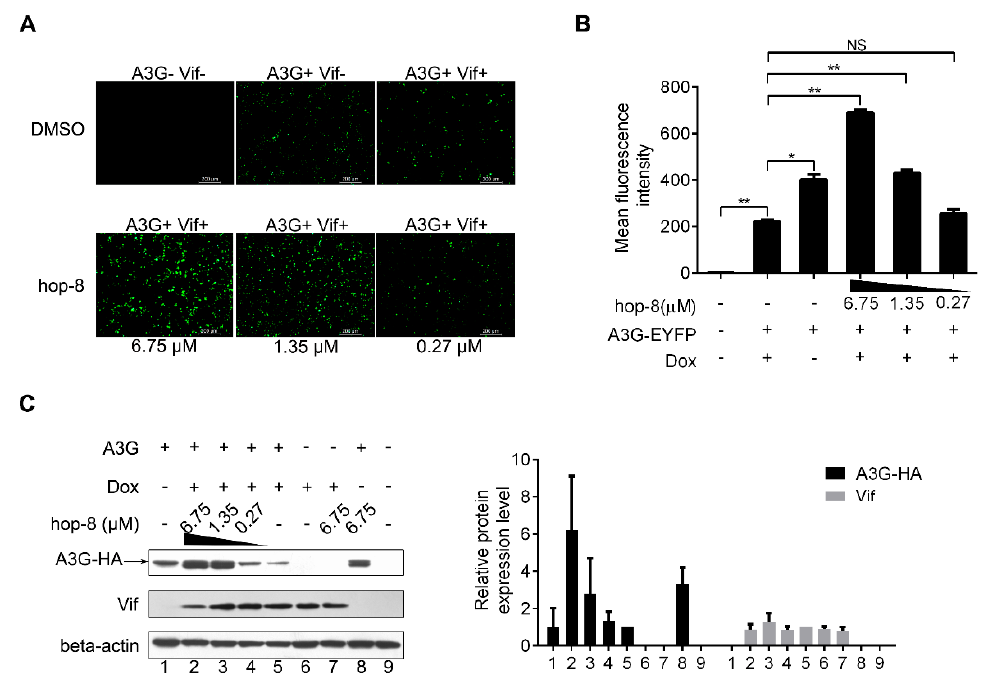
Figure 3. Hop-8 restored A3G levels in cells undergoing Vif-mediated A3G degradation. ( A ) Fluorescence